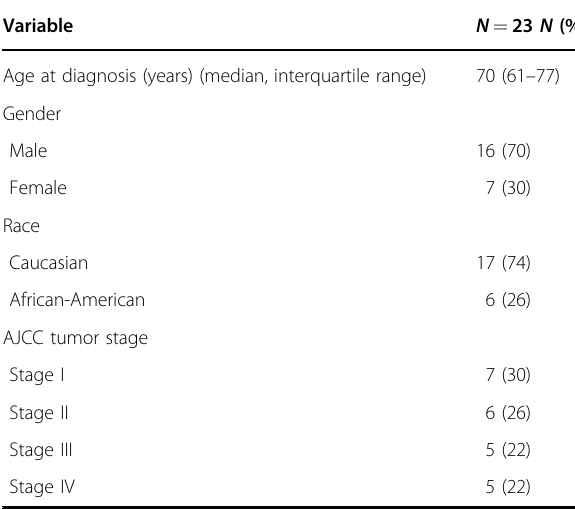
Table 1 Clinical details of patients from the University of Louisville